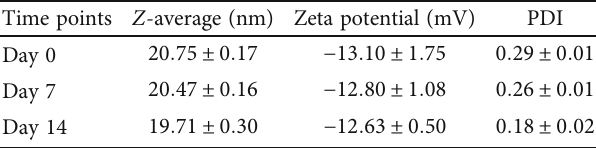
Table 5: Stability evaluation of